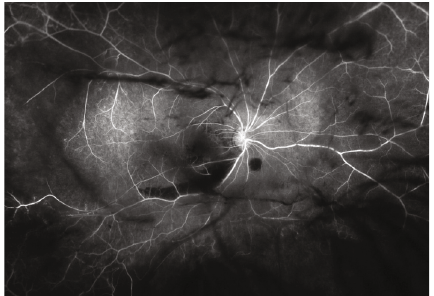
Figure 2: Wide fi eld fl uorescein angiography of the right eye demonstrating blocked fl uorescence from vitreous debris and hemorrhage, with mild decreased perfusion at the areas of retinoschisis, and multiple areas of blocked fl uorescence from intraretinal hemorrhage in the macula and near the periphery. There is no visible